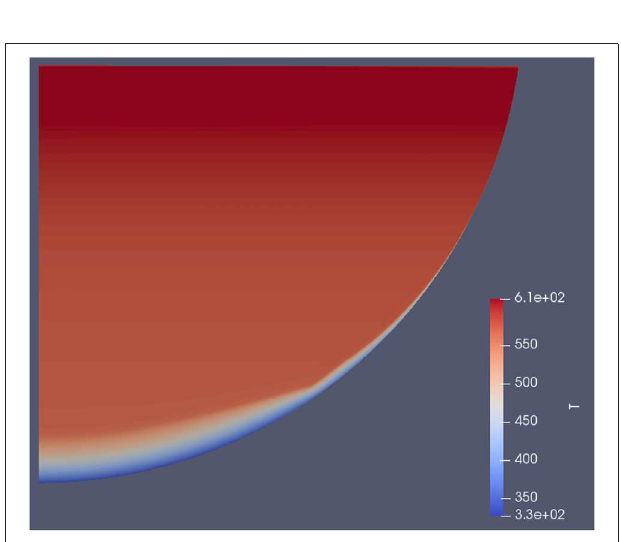
FIGURE 2 | Comparison of experimental and simulated temperature distribution.